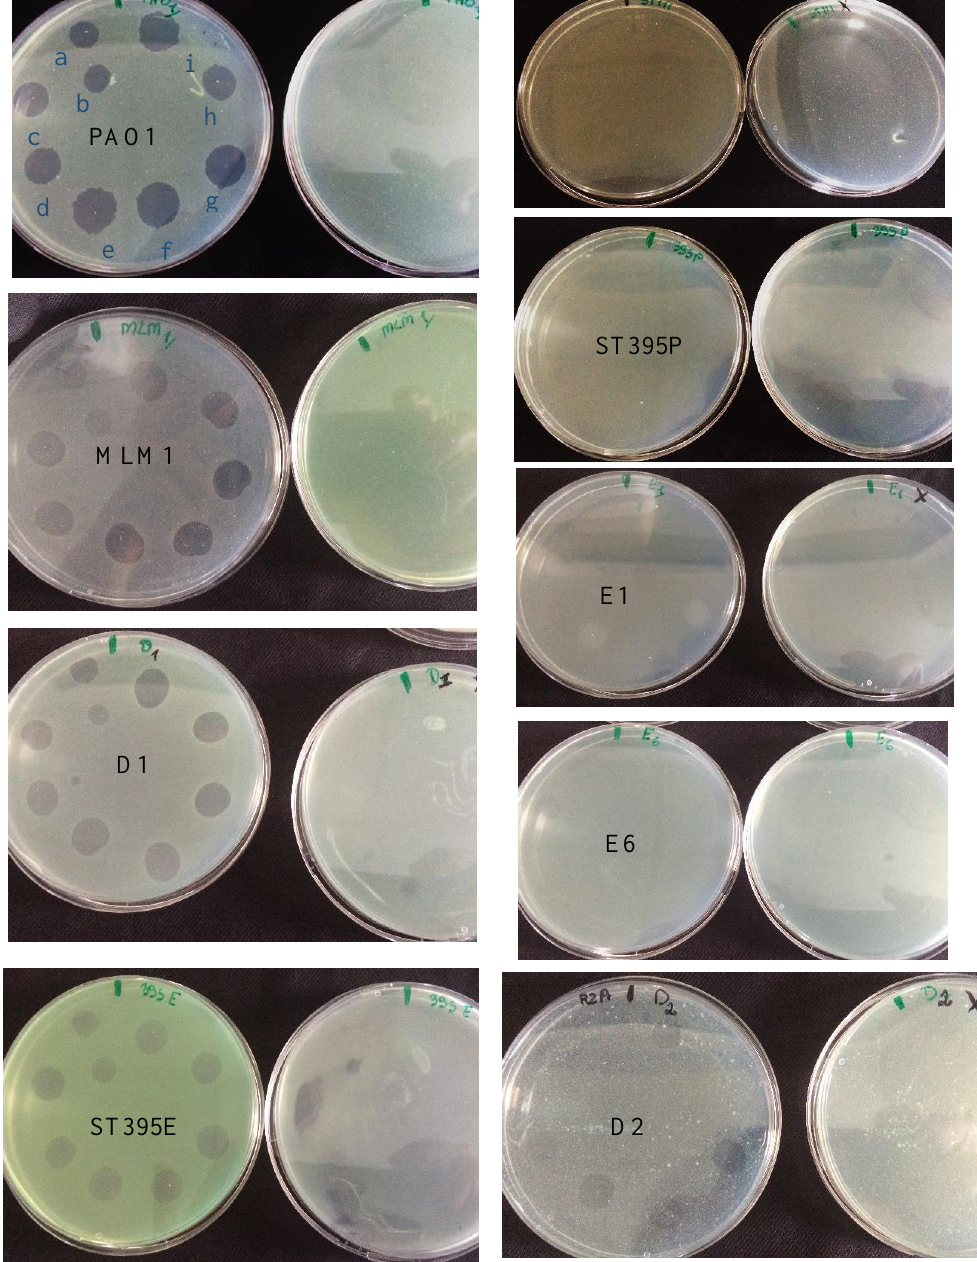
Figure A1. Plaque lysis forming from one spot test assay with concentrated phage suspensions. Each picture corresponds to the phage activity resulting from one of the nine P. aeruginosa strains (on the left: Petri dishes with spot test assays, on the right: Petri dishes without spot test and used as positive growth control). From the top to the bottom: left column, P. aeruginosa strain collection of PAO1, MLM, D1, and ST395E; right column, strains ST111, ST395P, E1, E6, and D2. Entitled spots: ( a ) B1, ( b ) LR1, ( c ) PEV2, ( d ) LUZ7, ( e ) 14.1, ( f ) LDK16, ( g ) EL, ( h ) MP22, ( i ) LUZ19. Lighter areas at the deposit locations correspond to bacterial lysis by phages. Different results were obtained according to the strain tested.